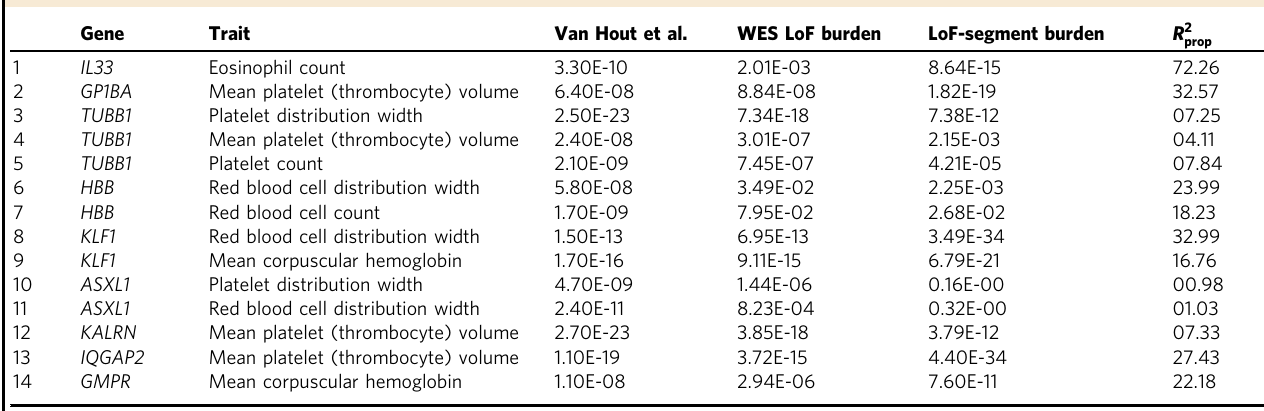
Table 1 Comparison between association